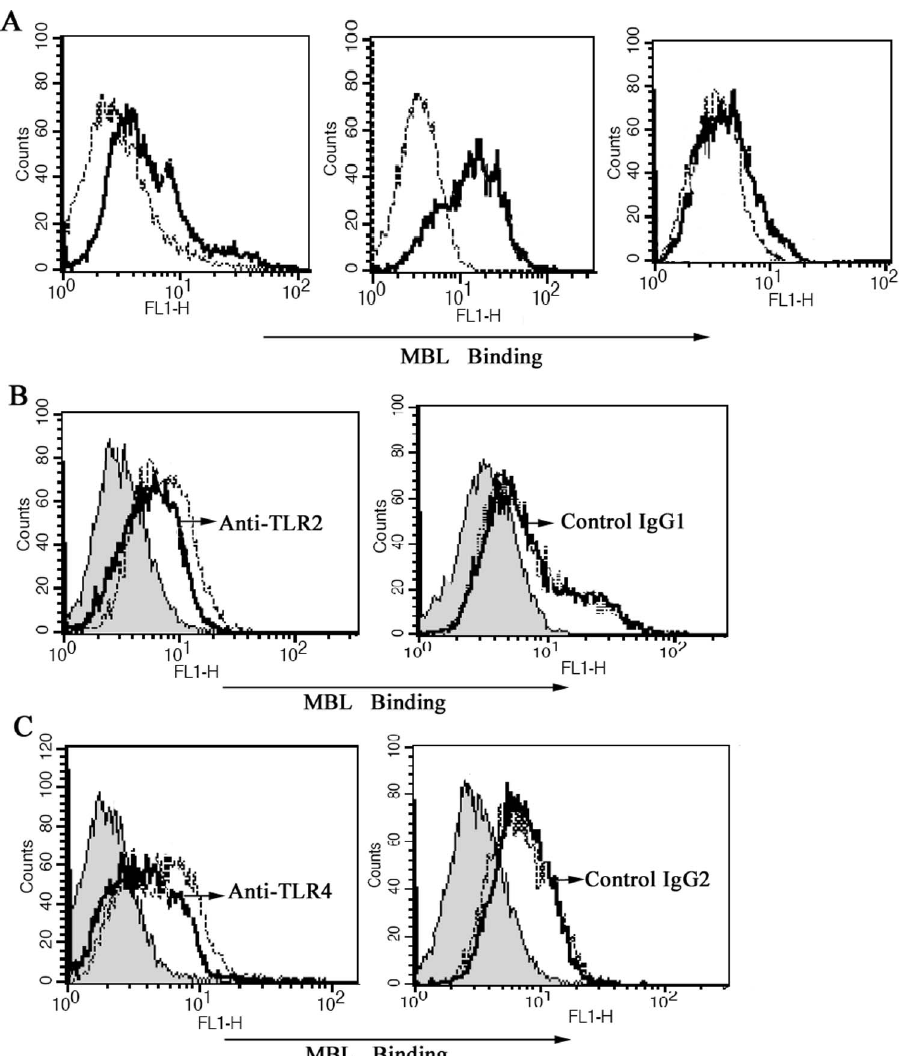
Figure 8. Inhibition of binding of MBL to PMA-activated THP-1 cells by anti-TLR2 mAb and anti-TLR4 mAb. (A) MBL binds to PMA- activated THP-1 cells in a Ca 2 + -dependent manner. PMA-activated THP-1 cells were incubated with biotinylated MBL in Tris-buffered saline solution containing various concentration of calcium ion. (a) Tris-buffered saline with 1.3 mM CaCl 2 ; (b) Tris-buffered saline with 5 mM CaCl 2 ; (c) Tris-buffered saline with 5 mM EDTA. Each solution of THP-1 cells was incubated for 30 min at 37 u C, binding of MBL to the cells was analyzed by FCM, as shown in the representative histograms. Black lines, biotinylated MBL binding. Dotted lines, negative controls (the cells only). (B) Anti-TLR2 mAb attenuates the binding of MBL to PMA-activated THP-1 cells. PMA-activated THP-1 cells were incubated with anti-TLR2 mAb or control mouse isotype IgG1, for 10 min before the addition of biotinylated MBL, and the binding of MBL was revealed by ExtrAvidin-FITC. Shaded curves, cells only, black solid line, with anti-TLR2 mAb, dotted line, without anti-TLR2 mAb. Data shown are representatives of four independent experiments. (C) Anti-TLR4 mAb attenuates the binding of MBL to PMA-activated THP-1 cells. PMA-activated THP-1 cells were incubated with anti-TLR4 mAb or control mouse isotype IgG2, for 10 min before the addition of biotinylated MBL, and the binding of MBL was revealed by ExtrAvidin-FITC. Shaded curves, cells only, black solid line, with anti-TLR4 mAb, dotted line, without anti-TLR4 mAb. Data shown are representative of four independent experiments.